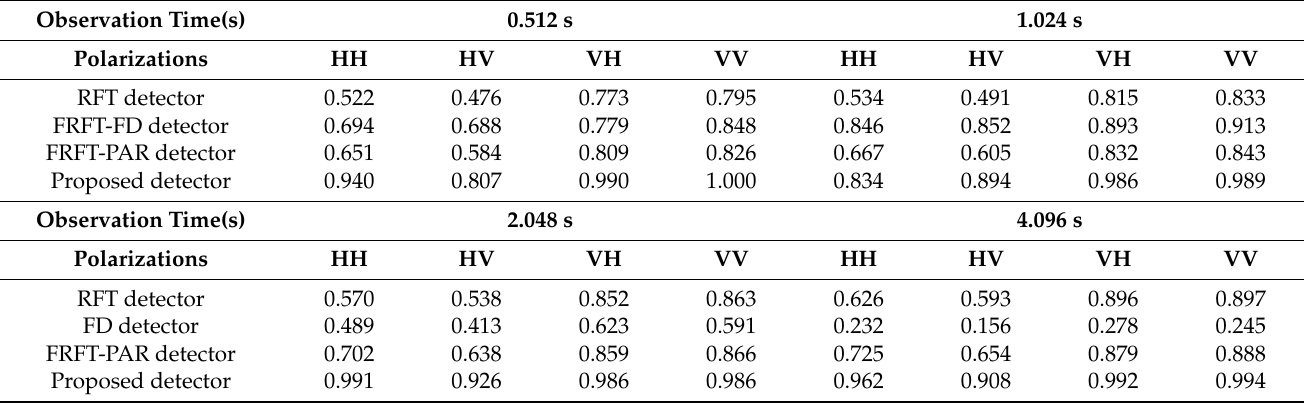
Table 4. Average detection probabilities of the detectors on the 20 datasets at four polarizations.